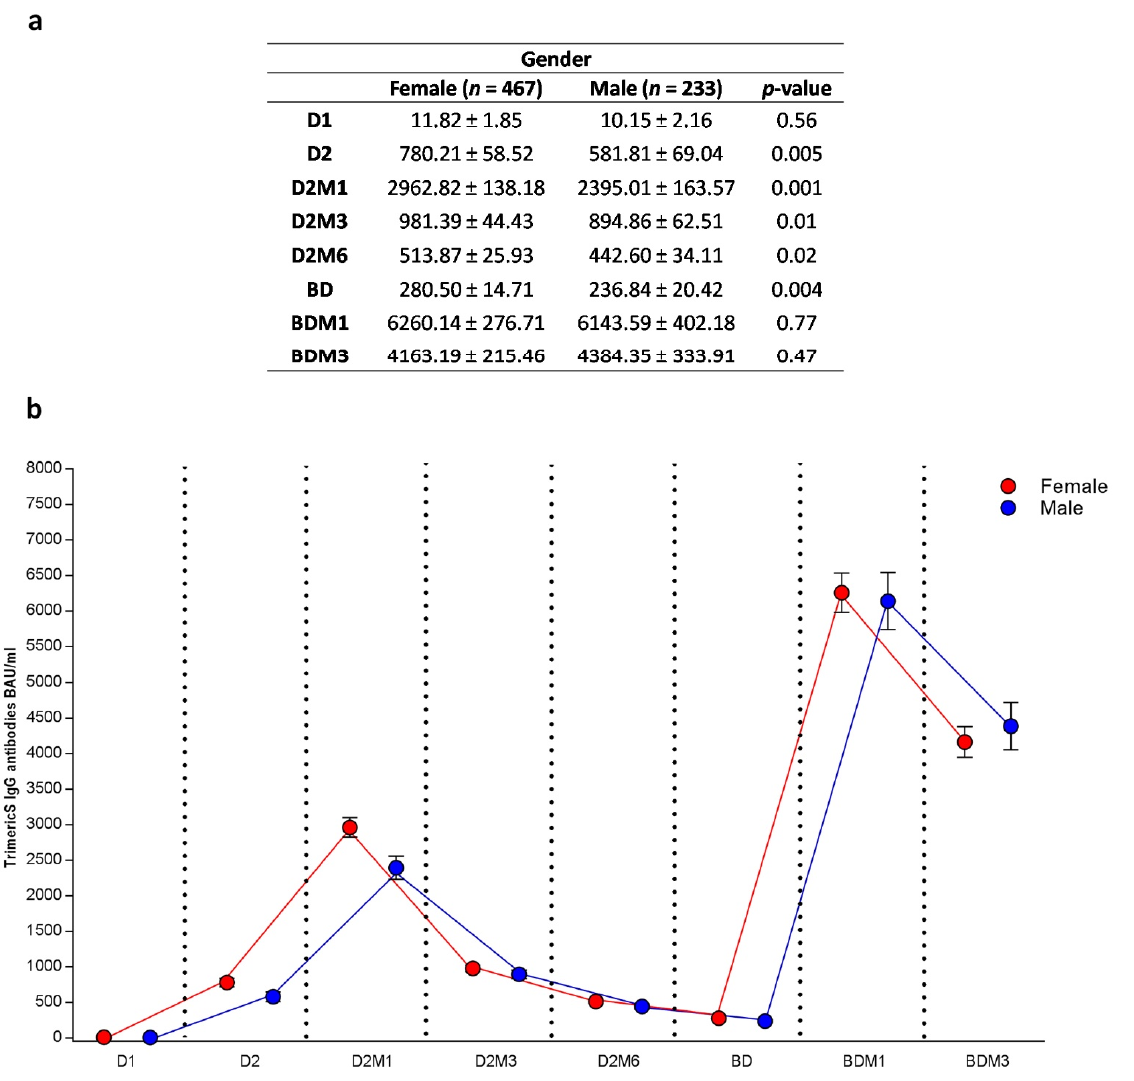
Figure 5. Anti-Trimeric Spike IgG geometric mean titer ( a ) and dynamic ( b ) before and after booster vaccination according to gender (mean ± SE). The nonparametric Kruskal–Wallis test was used for comparison of continuous values between groups. D1, dose 1; D2, dose 2; D2M1, 1 month after dose 2; D2M3, 3 months after dose 2; D2M6, 6 months after dose 2; BD, booster dose; BDM1, 1 month after booster dose; BDM3, 3 months after booster dose; and SARS-CoV-2, severe acute respiratory syndrome-coronavirus-2.